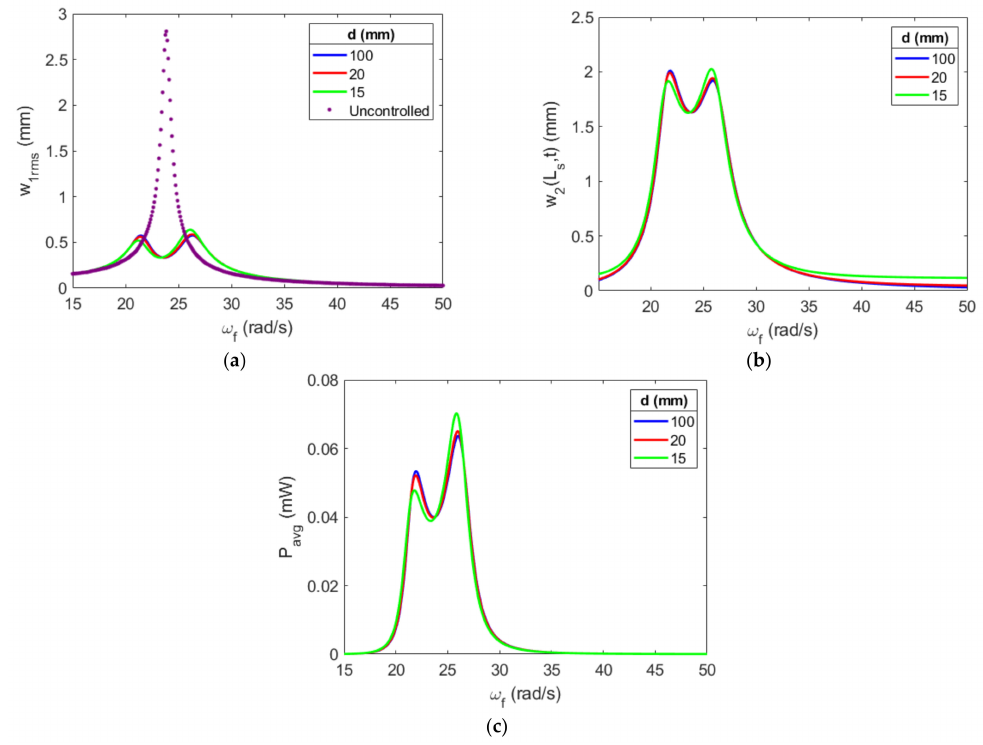
Figure 10. Response of the single attractive configuration for the ( a ) primary structure, ( b ) absorber’s displacement ( c ) and average power